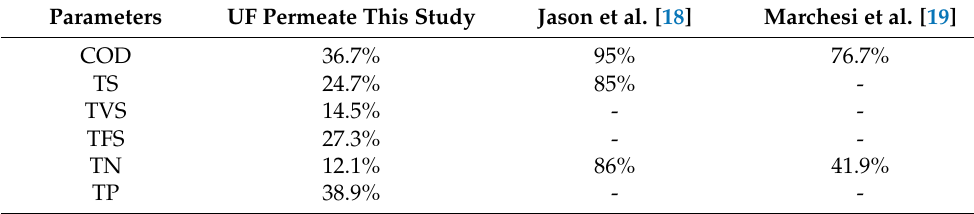
Table 6. Comparison of UF effectiveness with previous research.